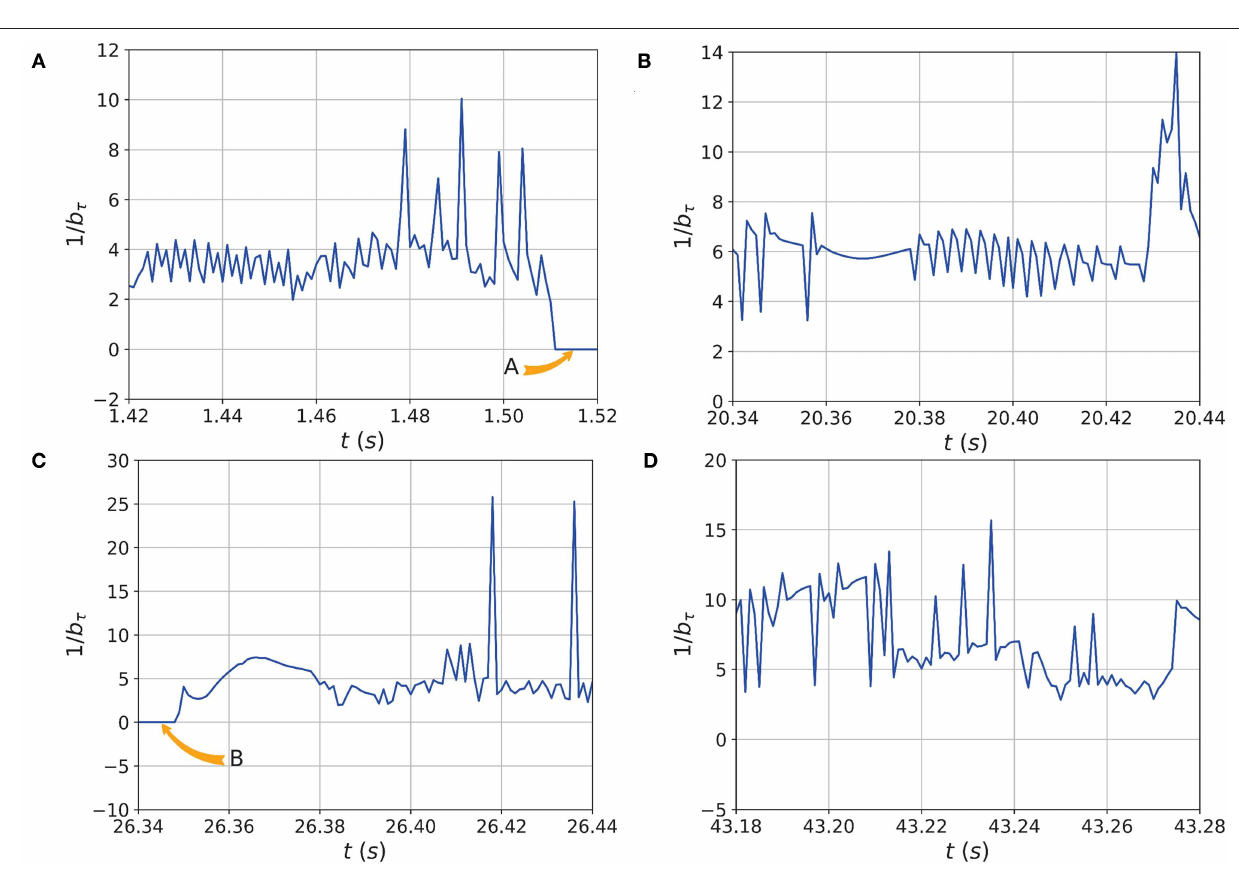
FIGURE 10 | The urgency of safety based on the minimal Time-to-Contact (TTC) of the edges and corners of the BoS. As the velocity of CoM changes, the TTC will also vary as shown in (A–D) . When the velocity becomes 0, b τ becomes infinity, and the urgency of safety will be 0 as shown in (A,C) marked as A and B respectively. This is exactly consistent with the results of the index shown in Figures 8A,C